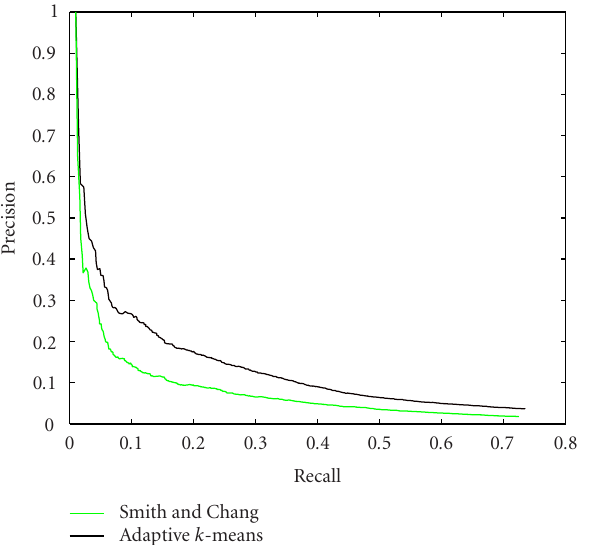
Figure 4: Precision/recall curves for two quantization methods: Smith and Chang with 166 bins and our adaptive method with 25 colors.